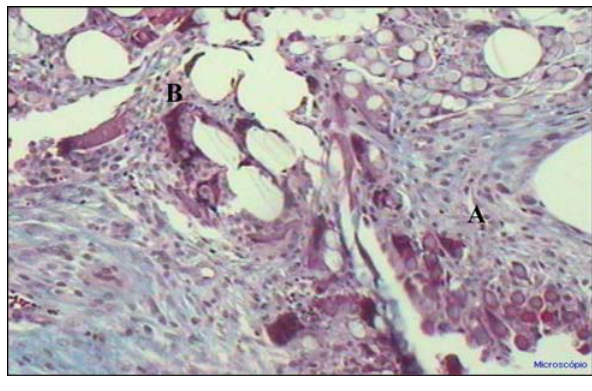
FIGURE 10 - Light microscopy findings after Vypro mesh